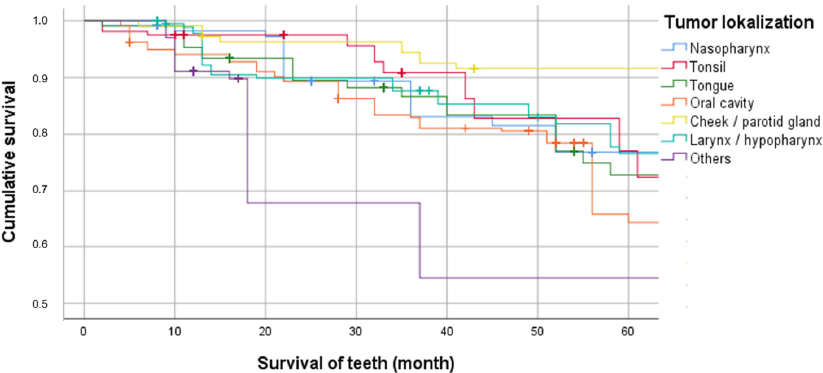
Figure 2. Cumulative survival of teeth in irradiated patients depending on the tumor